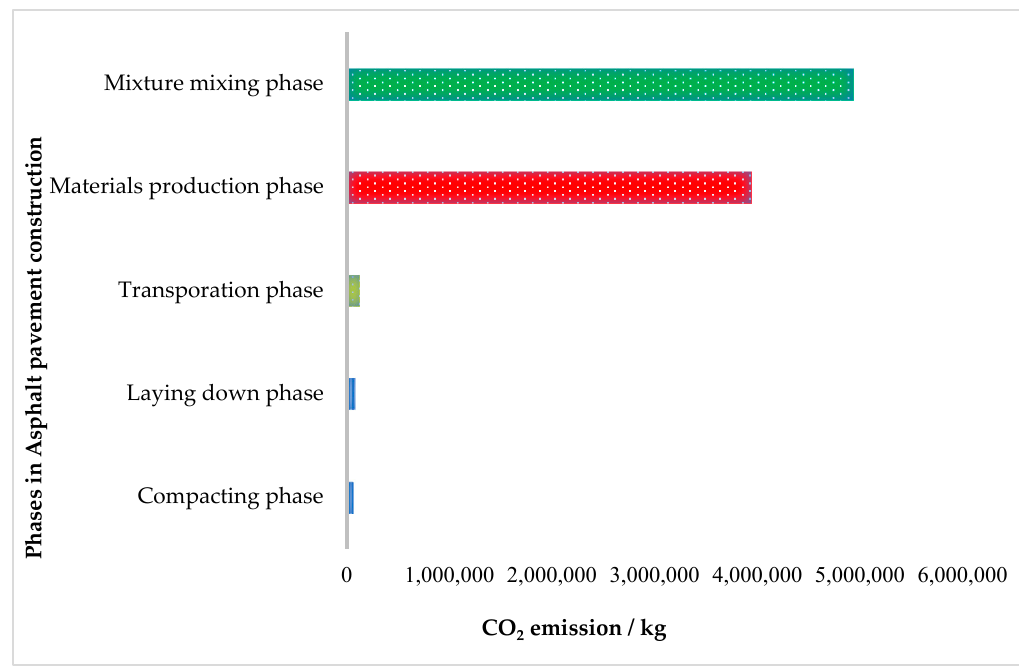
Figure 7. CO 2 emission in asphalt pavement construction.